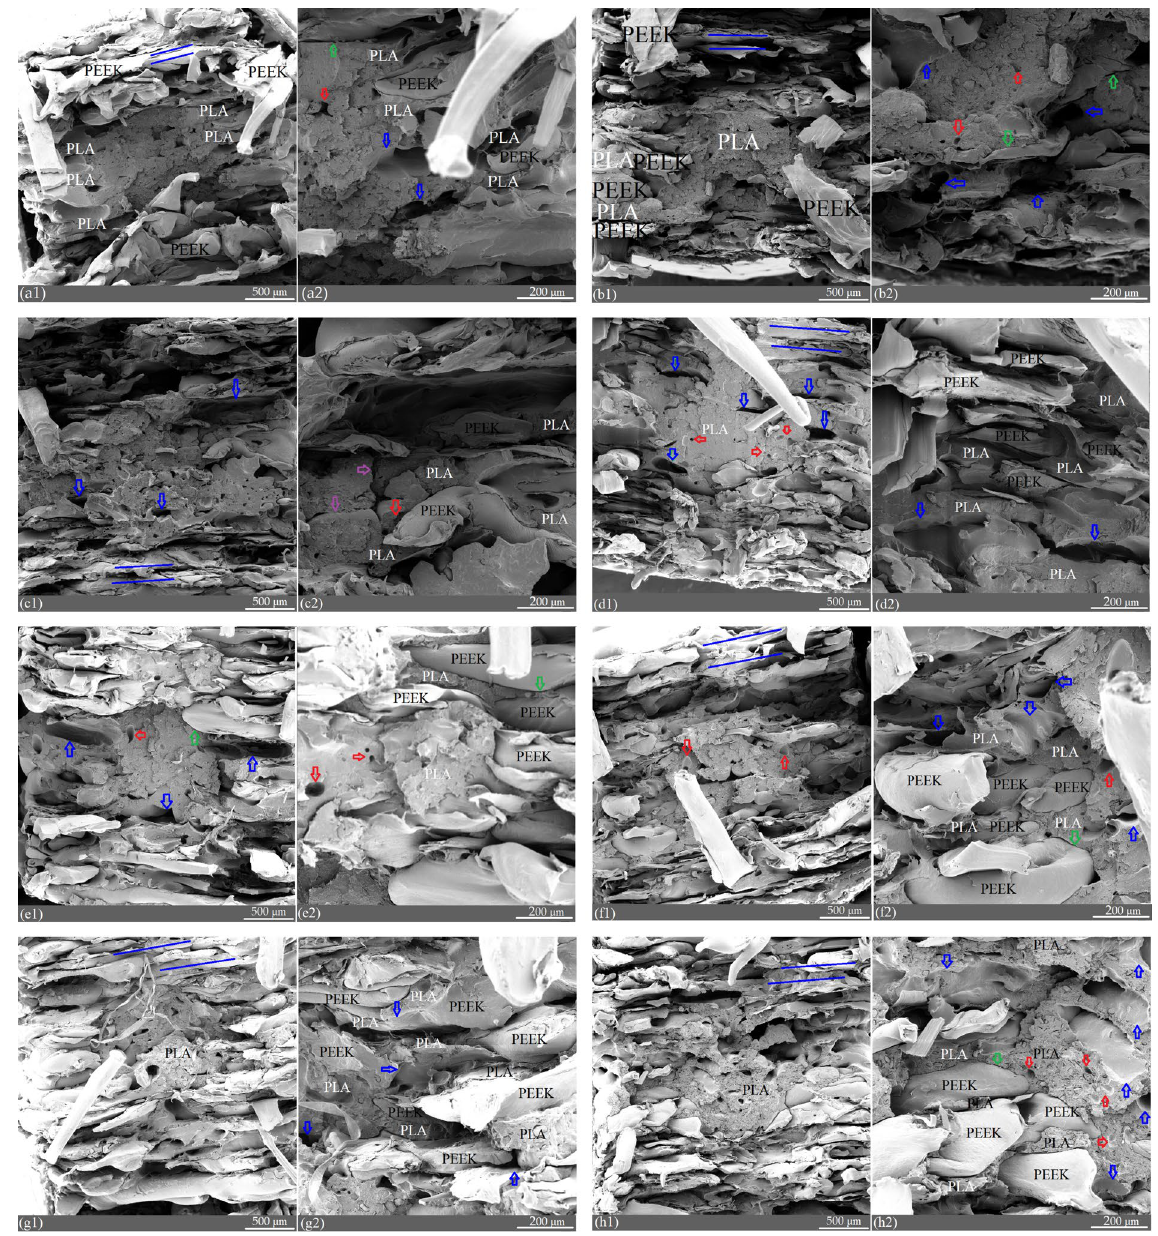
Figure 14. Tensile fracture morphology of PEEK-PLA/WA/HA scaffolds: ( a1 )–( h1 ), S1, S2, S3, S4-1, S4-2, S4-3, S4-4, S4-5; ( a2 )–( h2 ), the enlarged figure of (a1)-(h1),